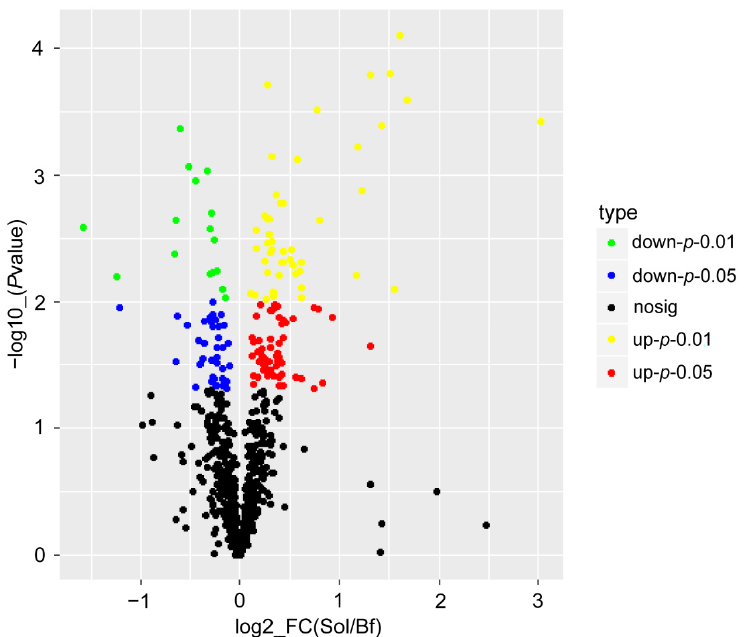
Figure 3. Identification of DAPs between fast-twitch and slow-twitch muscles. A volcano plot was drawn to show the DAPs between Bf and Sol. The green dots indicate significantly downregulated proteins ( p < 0.01 and fold change <0.83), the blue dots indicate significantly downregulated proteins ( p < 0.05 and fold change <0.83), the yellow dots indicate significantly upregulated proteins ( p < 0.01 and fold change >1.2), the red dots indicate significantly upregulated proteins ( p < 0.05 and fold change >1.2), and the black dots represent proteins with non-significant ( p > 0.05 or 0.83 < fold change <1.2) differences in expression.